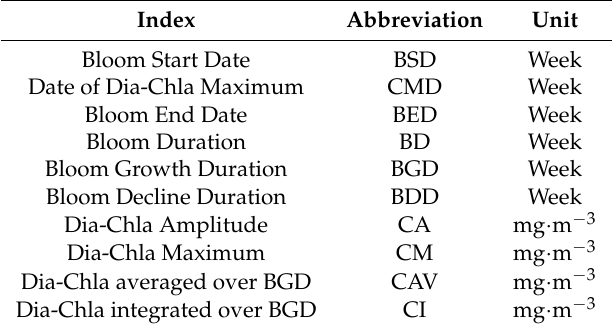
Table 2. Phenological indices as used in this